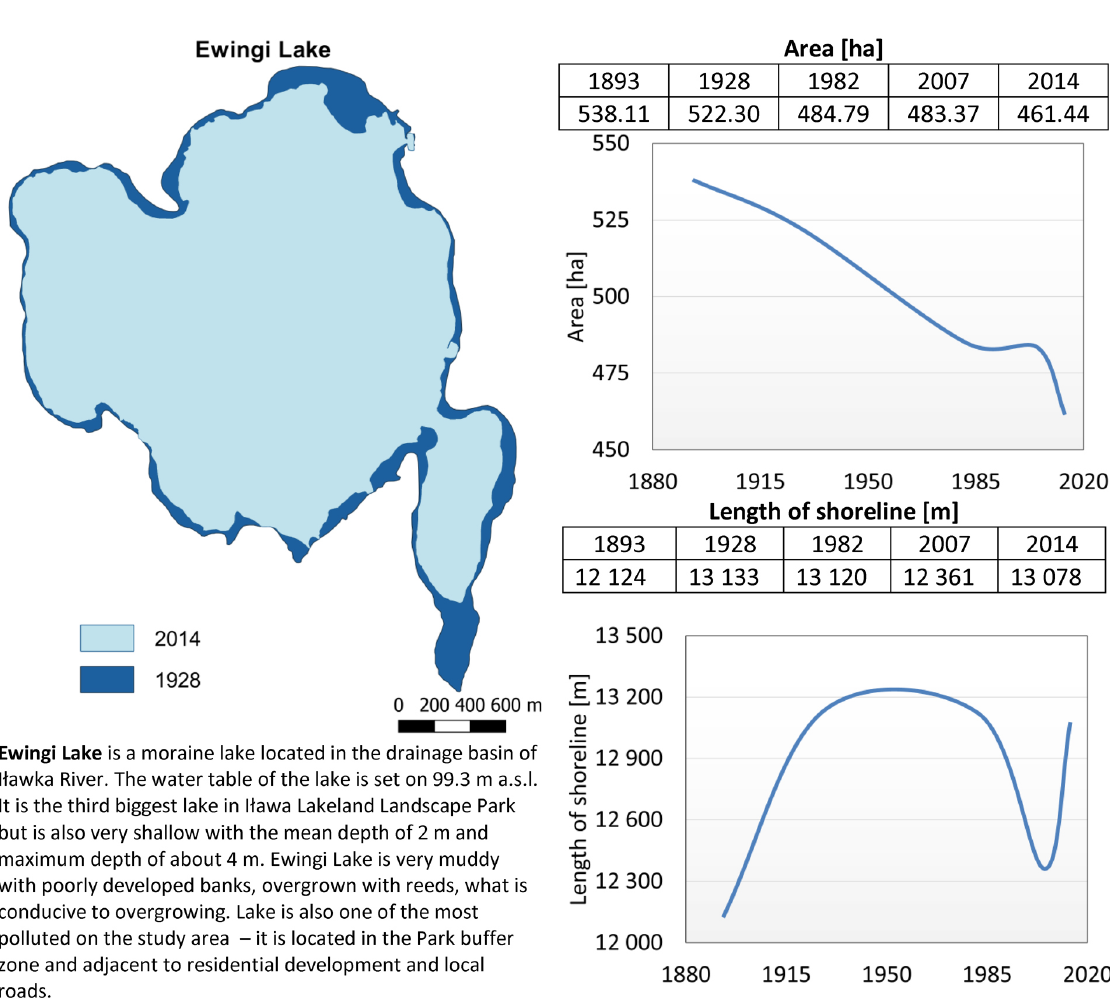
Fig. 3. Document card of Ewingi